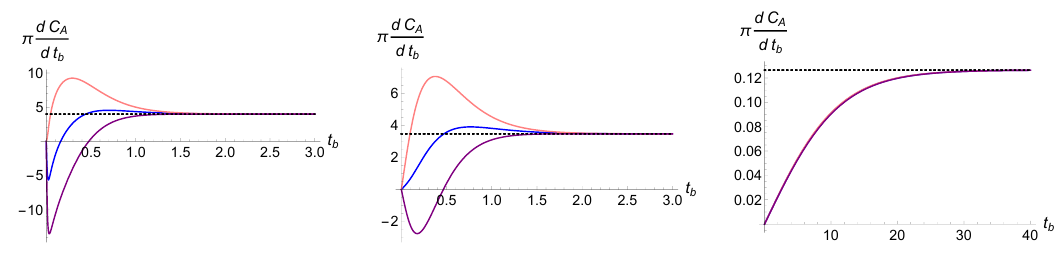
Figure 3 . π dC A in eq. (2.39) with M = 2 , ‘ = G N = 1 and (left) J = 0 . 1 , (center) J = 1 , (right) dt b J = 1 . 999 . In the three panels we explore the dependence on the counterterm scale: L ct = 0 . 1 (pink), L ct = 1 (blue), L ct = 10 (purple), increasing from the top down. In black dotted the late time value